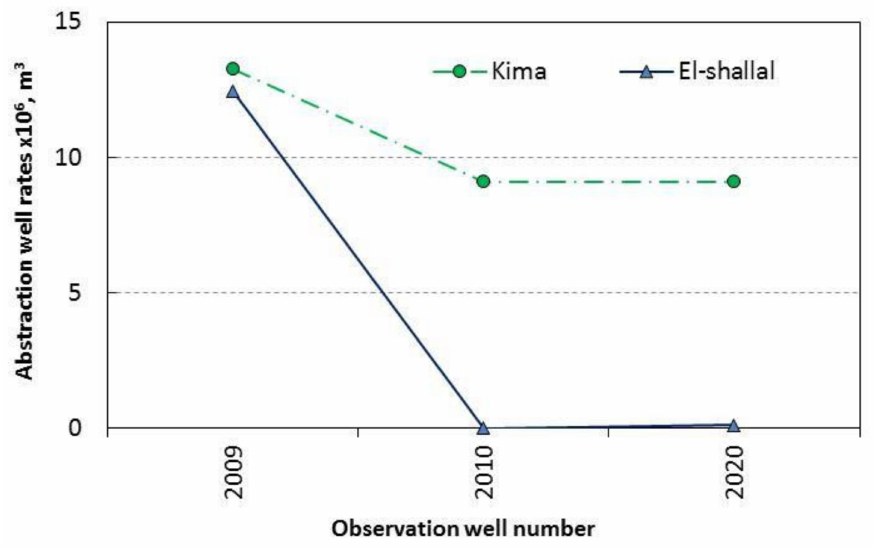
Figure 6. Quantities of withdrawal from study